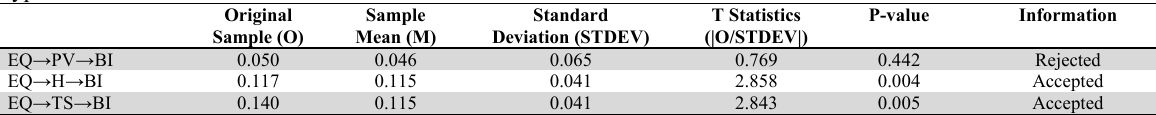
Hypothesis Test Results of Indirect Effect